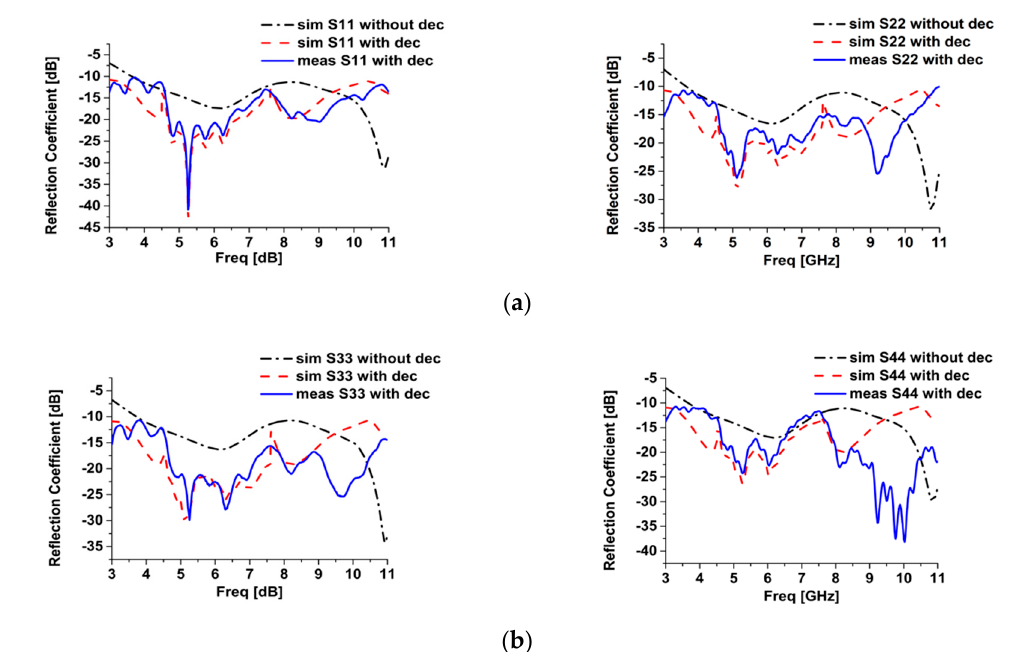
Figure 6. Simulated and Measured reflection coefficient ( a ) antenna 1 and 2; ( b ) antenna 1 and